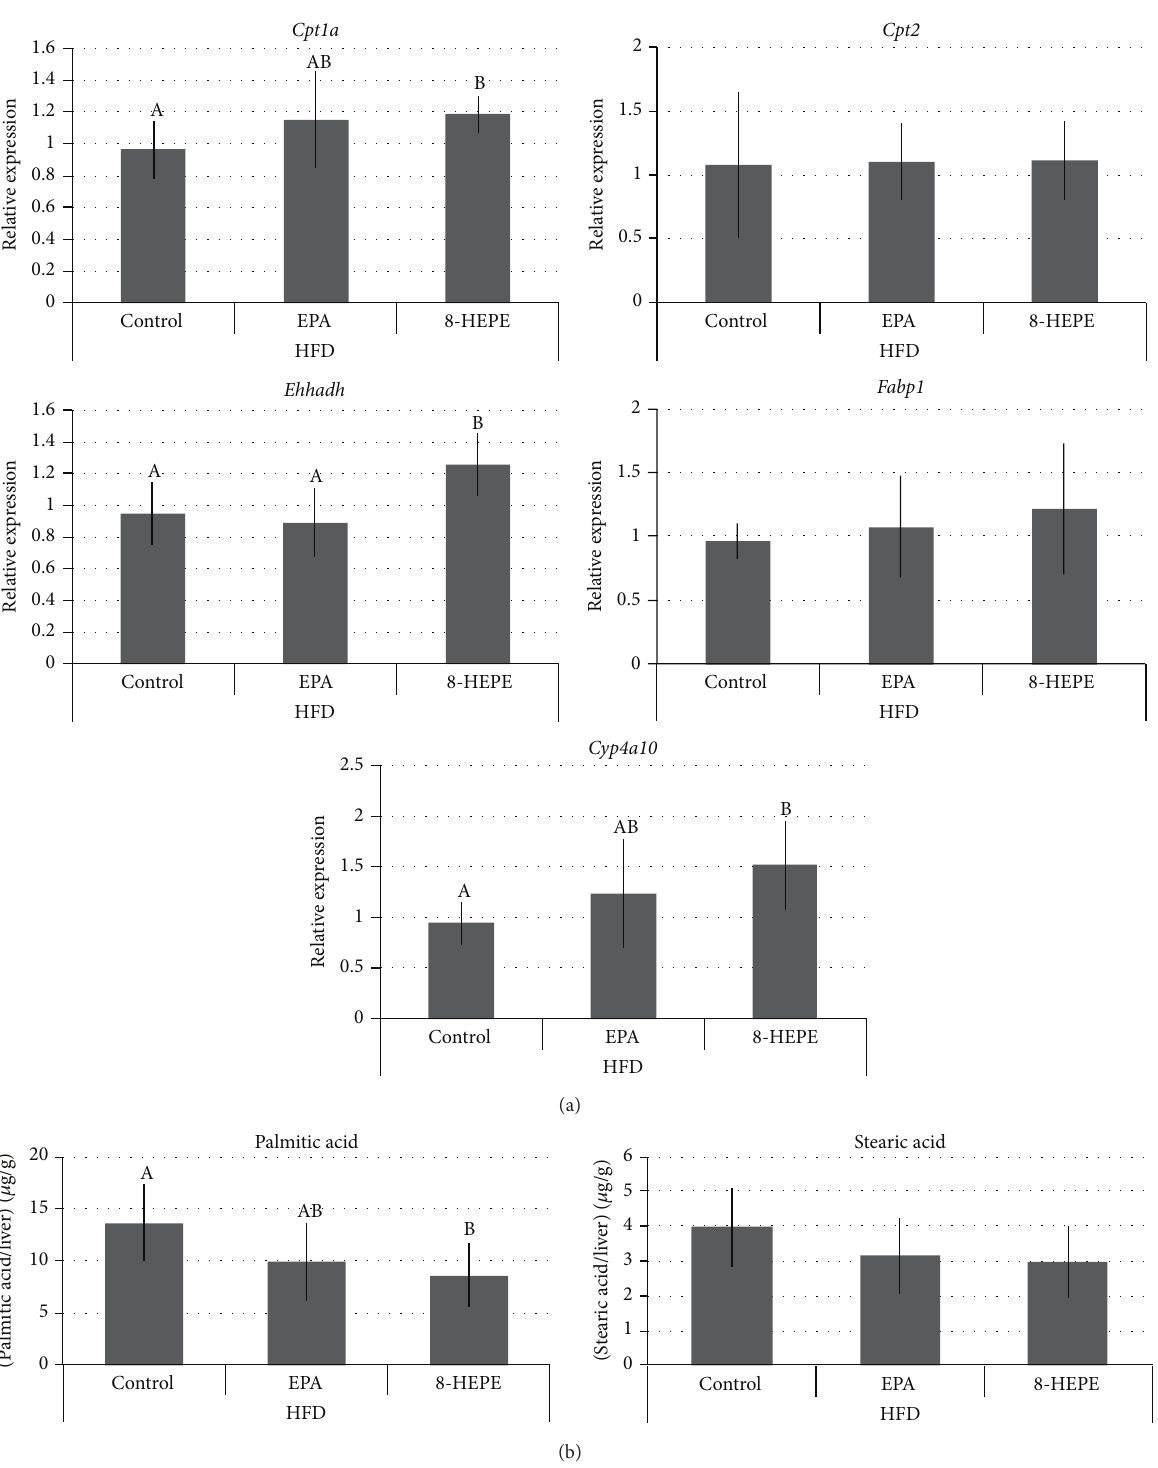
Figure 1: Changes in hepatic gene expression (a) and in concentrations of long-chain saturated fatty acids (b) in male C57BL/6J-DIO mice fed HFD, HFD with EPA, or HFD with 8-HEPE for 4 wk. Gene expression levels were measured by real-time PCR and normalized against expression of Actb . Values are means ± SDs, 𝑛 = 9 . Labeled means without a common letter differ; 𝑃 < 0.05 . HFD: high-fat diet; HEPE: hydroxyeicosapentaenoic acid; EPA: eicosapentaenoic